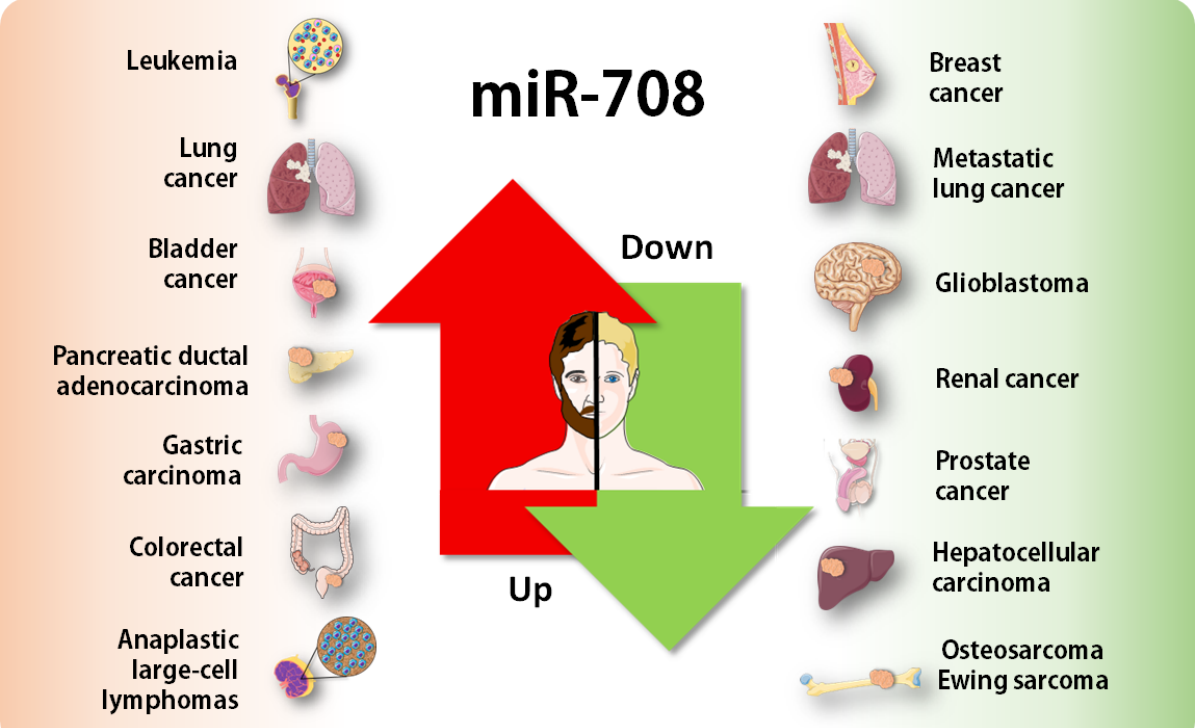
Figure 3. Janus-faced behavior of miR-708, acting as an oncogene ( left ) or tumor suppressor ( right ), depending on the tissue histology or cellular context. The figure was composed with the aid of illustrations from the SMART — Servier Medical Art available at https://smart.servier.com/. Downregulation of miR-708 has been revealed in glioblastoma and in renal cancer,